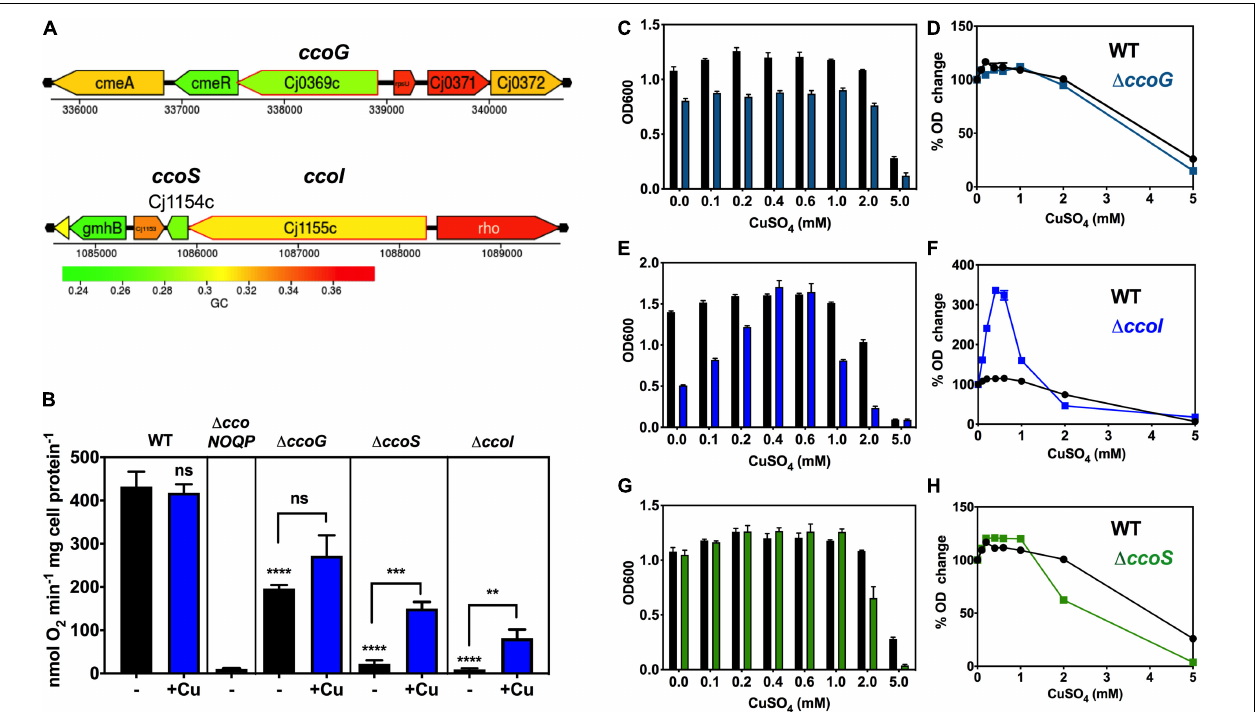
FIGURE 2 | Dependence of oxidase activity and growth on putative ccoG , ccoI , and ccoS genes and the effect of exogenous copper. (A) Genomic regions of NCTC 11168 encoding putative ccoG ( upper panel ), ccoI and ccoS ( lower panel ) genes. Images derived from campyDB (http://xbase.warwick.ac.uk/campydb/) and genes coloured by GC composition (see scale). (B) Cytochrome c oxidase activity measured with ascorbate/TMPD as electron donor. Wildtype, (cid:49) ccoNOQP , (cid:49) ccoG , (cid:49) ccoI , and (cid:49) ccoS cells were grown in unsupplemented Mueller-Hinton medium (approx. 0.05 µ M copper) or with copper sulphate added to 0.6 mM (an excess but non-toxic level; see Figure 3 ). The data are the average of triplicate cultures with error bars showing SD. t -tests were performed to test significance ( p > 0.05, ns; 0.01 > ** p > 0.001; 0.001 > *** p > 0.0001; **** p > 0.0001). The stars above the black bars represent the statistical significance of comparisons between the unsupplemented mutant and wild-type rates. Panels (C–H) , copper sensitivity of growth of wild-type and ccoG , ccoI , and ccoS mutants. WT, (cid:49) ccoG (C) ; (cid:49) ccoI (E) ; and (cid:49) ccoS (G) cells were grown at different concentrations of CuSO 4 in Mueller-Hinton medium until stationary phase (24 h) and the final ODs were measured. The data are the average of triplicate cultures with error bars showing SD. In panels (D,F,H) , the corresponding raw data for each strain are normalised with respect to the final OD without Cu = 100%, to better visualise the degree of enhancement or inhibition of growth by